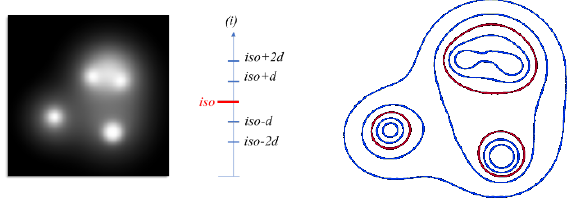
Figure 3. 2D curves concept: a desired iso and δ values are selected and corresponding levels from a scalar heightmap (left) are extracted and processed as curves (right). The iso reference level is in